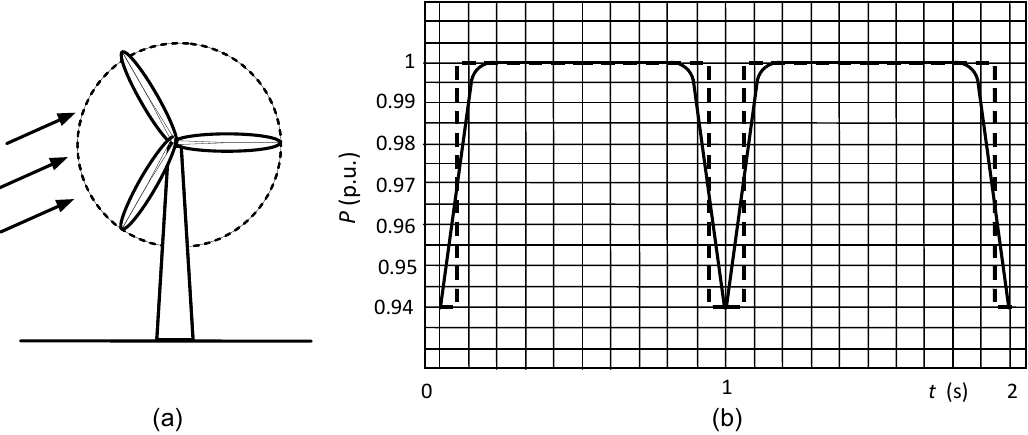
Figure 4. Tower shadow effect: ( a ) wind generator and ( b ) output power variation.